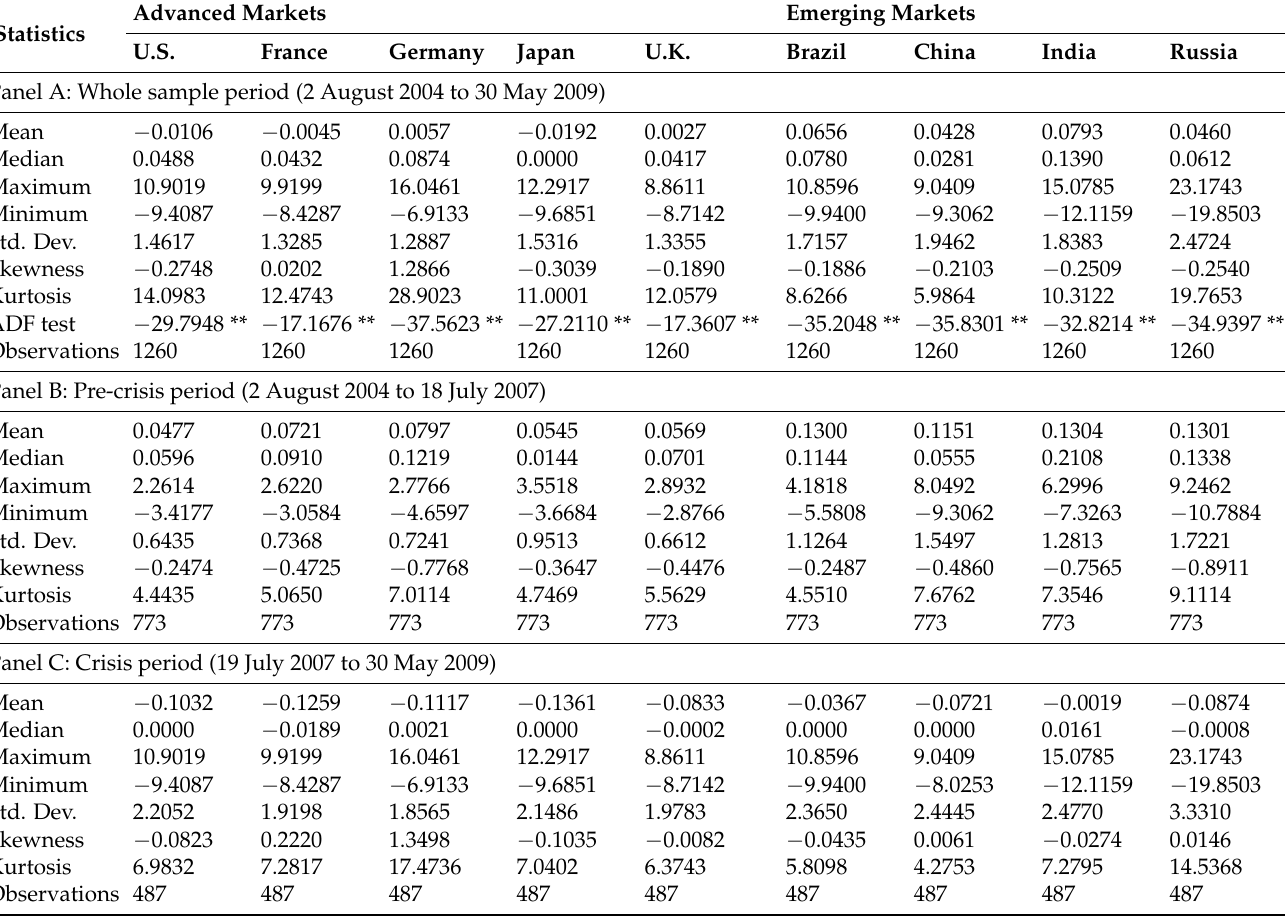
Table 2. Summary statistics of daily return for aggregate equity market